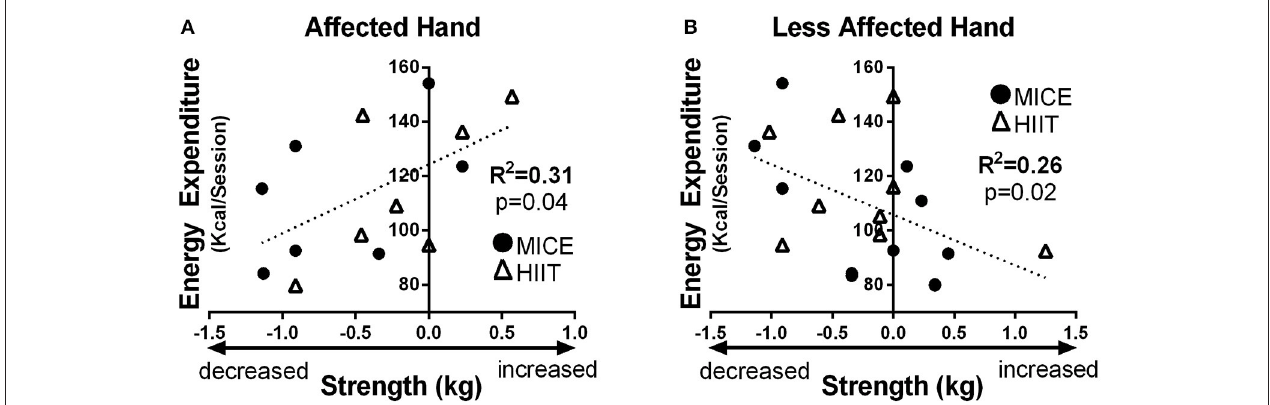
FIGURE 4 | Total energy expenditure of exercise related to: (A) enhanced pinch strength in the affected hand, and; (B) decreased pinch strength in the less affected hand. Solid circles MICE (moderate intensity continuous exercise), open triangles HIIT (high intensity interval training).